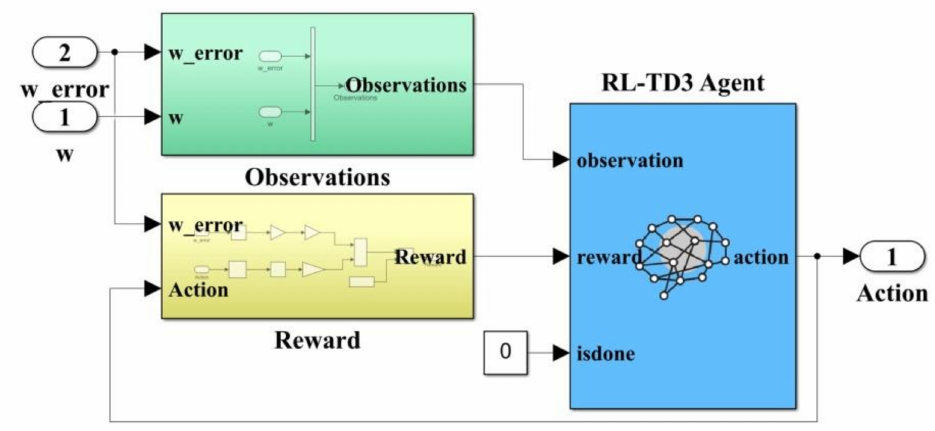
Figure 6. MATLAB/Simulink implementation of RL-TD3 agent for the correction of i qref